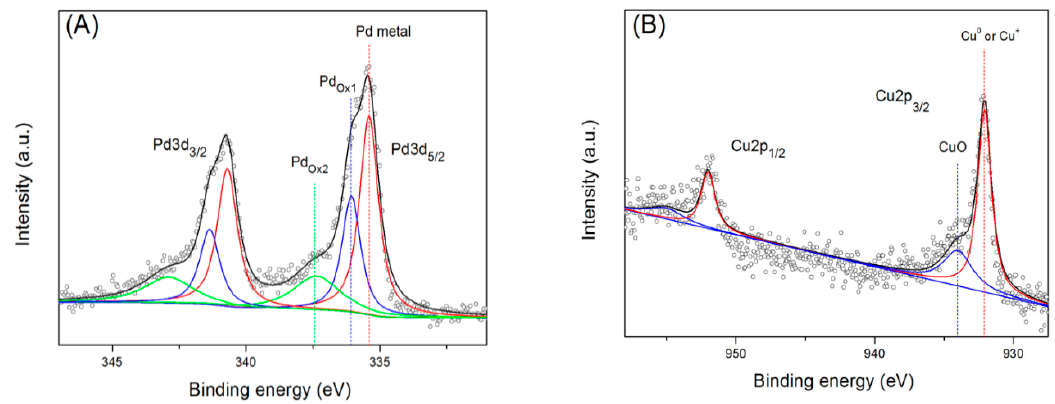
Figure 4. Core–shell XPS spectra of ( A ) Pd 3d and ( B ) Cu 2p .